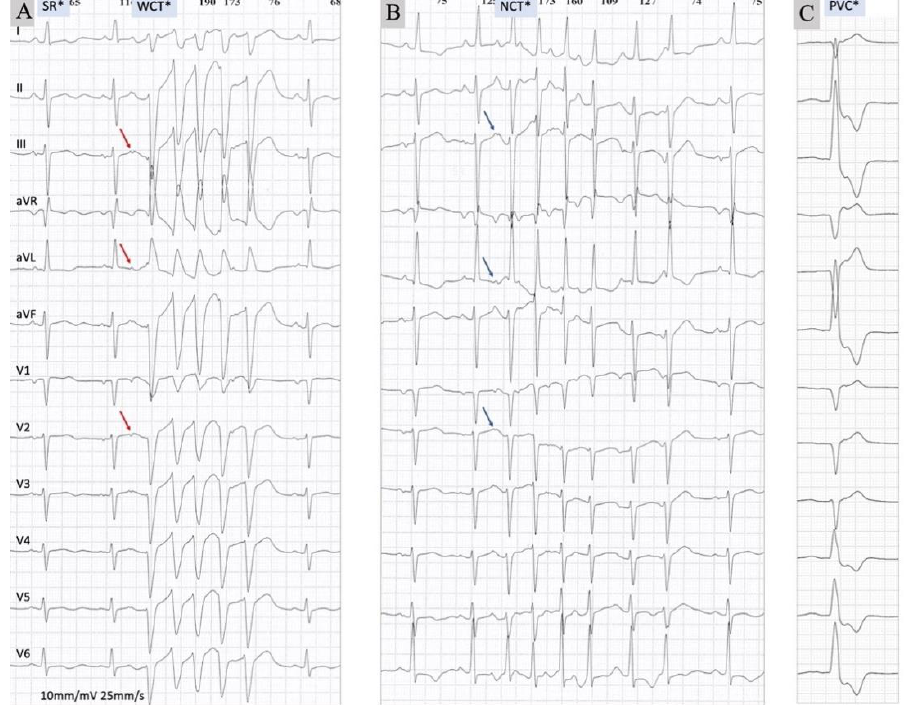
Figure 2. The 12-lead Holter recordings during ( A ) sinus rhythm (SR) and wide complex tachycardia (WCT), during ( B ) narrow complex tachycardia (NCT), and a during ( C ) premature ventricular contraction (PVC). Beats marked with an asterisk (SR*, WCT*, NCT*, or PVC*) are displayed as VCG loops in Figure 3.